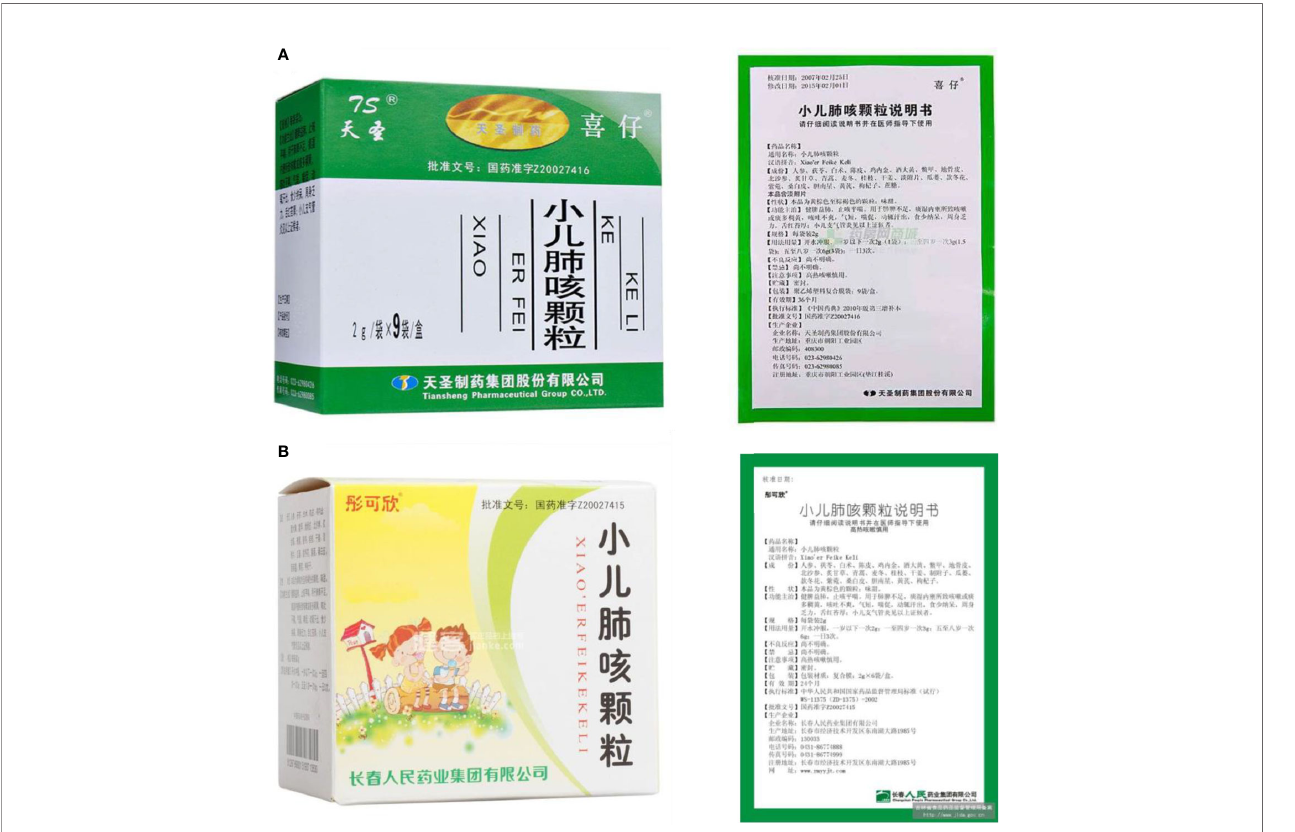
FIGURE 12 | XFG and its instructions from (A) Tian-sheng Pharmaceutical Group Co., LTD, Chong-qing, China, and (B) Chang-chun People Pharmaceutical Group Co., LTD, Chang-chun,